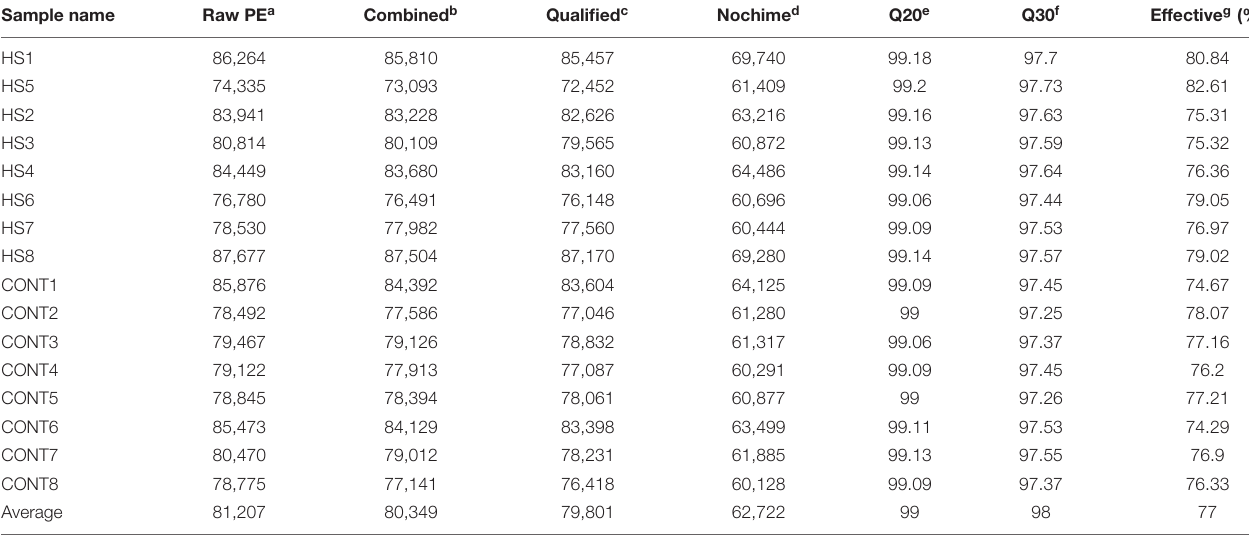
TABLE 1 | Data processing, statistics, and quality